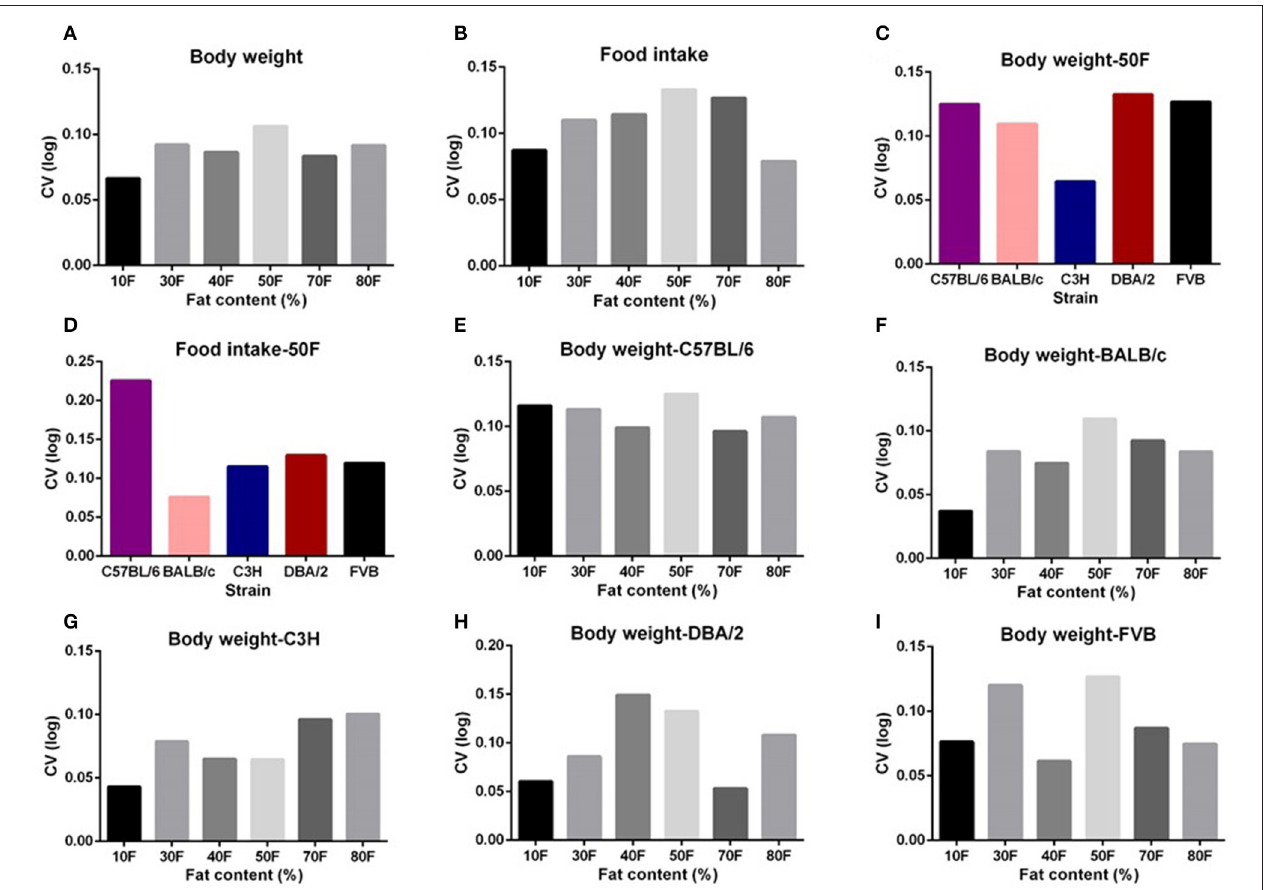
FIGURE 2 | The coefficient of variation (CV) of body weight and food intake of different strains and different diet treatment groups. The CV of body weight and food intake of (A,B) graded levels of fat content diet treatment group, (C,D) different strains ( n = 7–21). (E–I) Variations in body weight gain (CV) of five different strains (C57BL/6, BALB/c, C3H, DBA/2, and FVB) when fed with 10, 30, 40, 50, 70, and 80% content fat diets, respectively ( n =